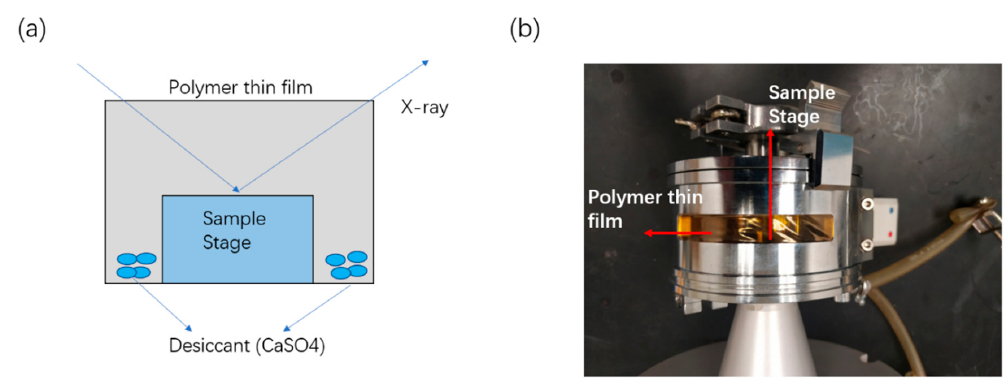
Figure 1. ( a ) Schematic illustration of the XRD chamber; ( b ) photo of the